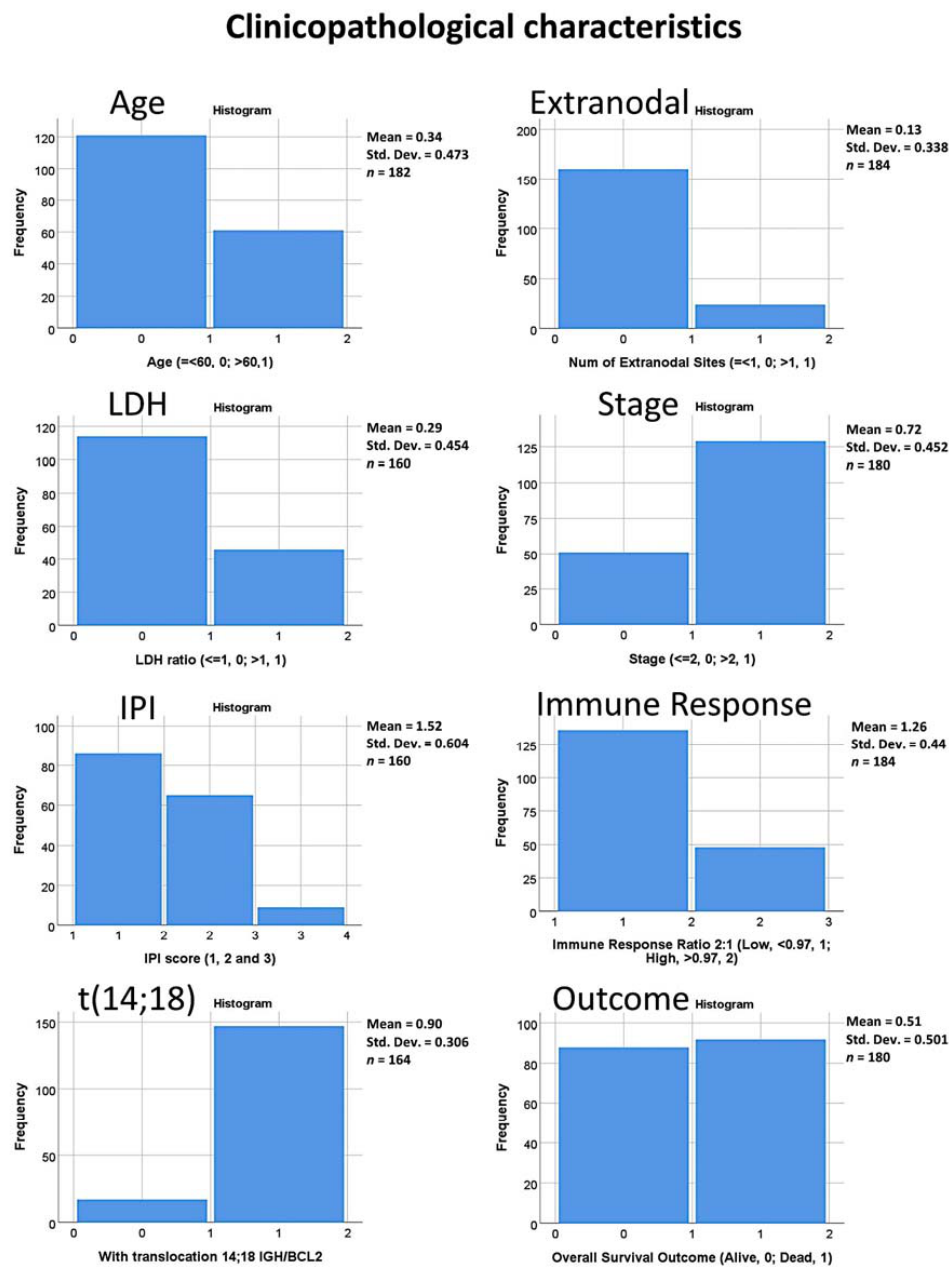
Figure 1. Clinicopathological characteristics of the series. The histograms show the distribution of the data for each of the clinical variables including the immune response gene signature 2:1 ratio and the presence of translocation (14;18) involving the IGH / BCL2